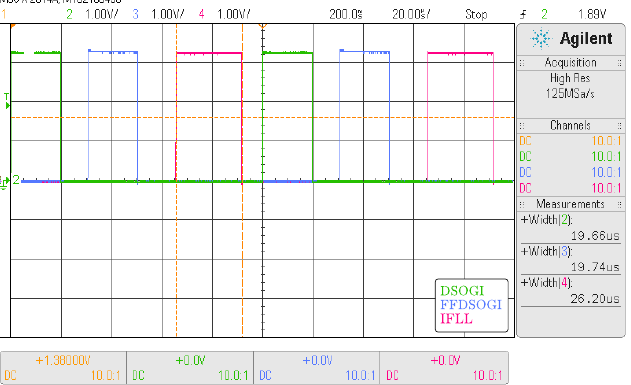
Figure 23. Algorithms process time, including ADCs acquisition